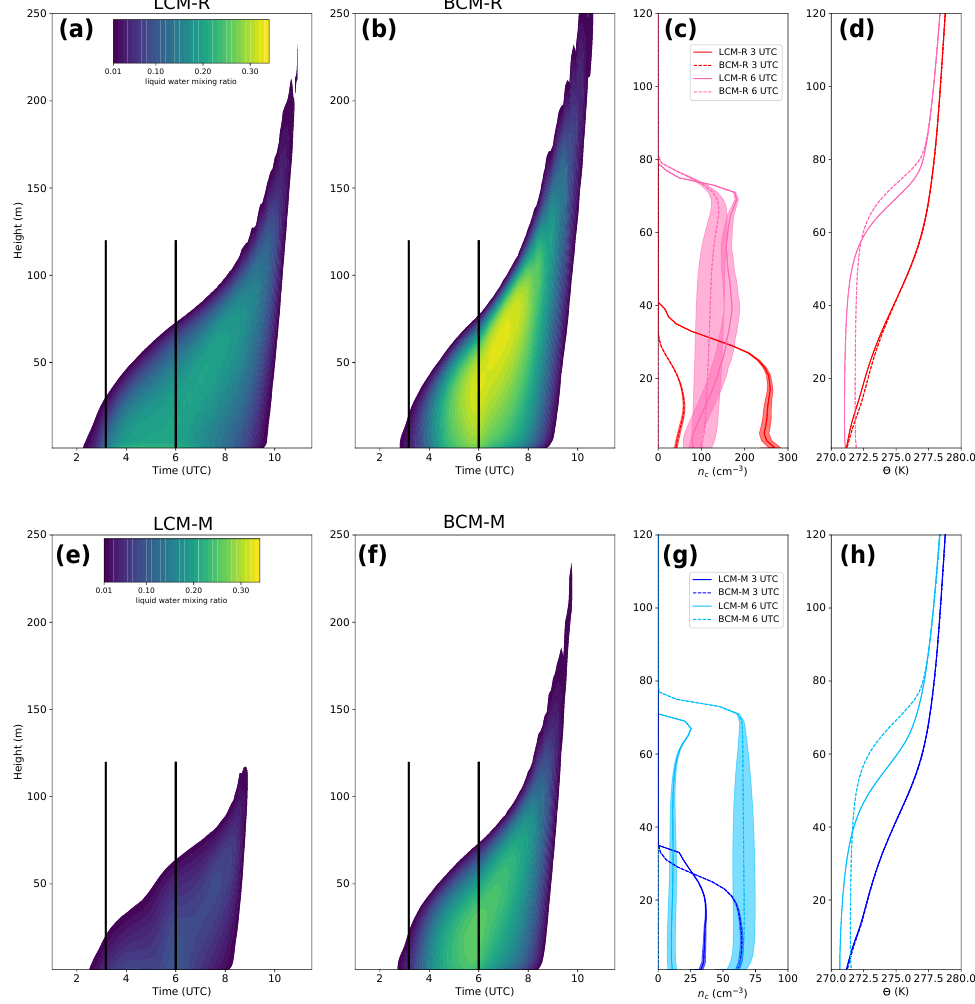
Figure 3. Time-height cross-section of liquid water ratio (horizontally averaged) for rural (top panel) ( a , b ) and maritime (bottom panel) ( e , f ) aerosol conditions. In the left column results for LCM cases and on the right column for BCM cases are shown. Profiles on the right hand side display n c ( c , g ) and potential temperature θ ( d , h ) at the marked times (black vertical line in the cross-section). The shaded areas ( c , g ) show the liquid water mixing ratio as a qualitative measure. Here, areas of the same size represent equal values for q l